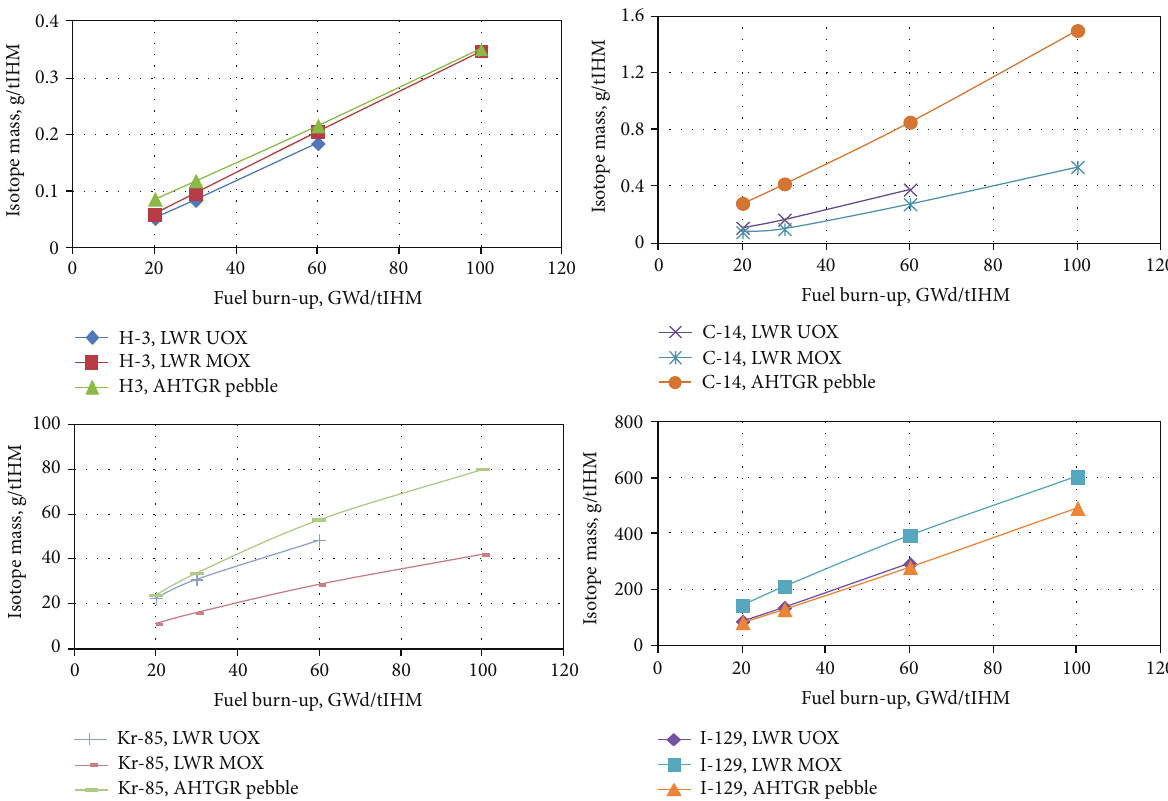
Figure 1: Amounts of volatile radionuclides in selected UNFs at the time of discharge (no cooling time), calculated with ORIGIN-ARP [9].